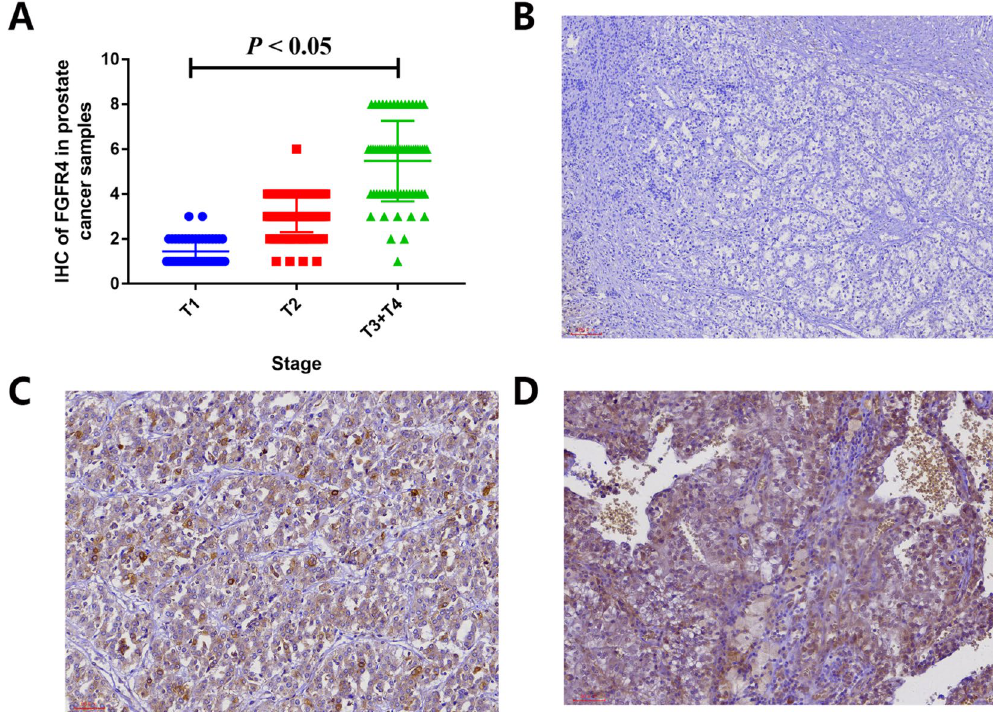
Figure 6. Tissue expression of FGFR4 among prostate cancer participants. The intensity of immunoreactivity was mainly concentrated in the cytoplasm of prostate cancer epithelial cells ( C , D ). The expression of FGFR4 is up-regulated in more advanced cases ( D ), as compared to ones in early stage ( A , B , P <